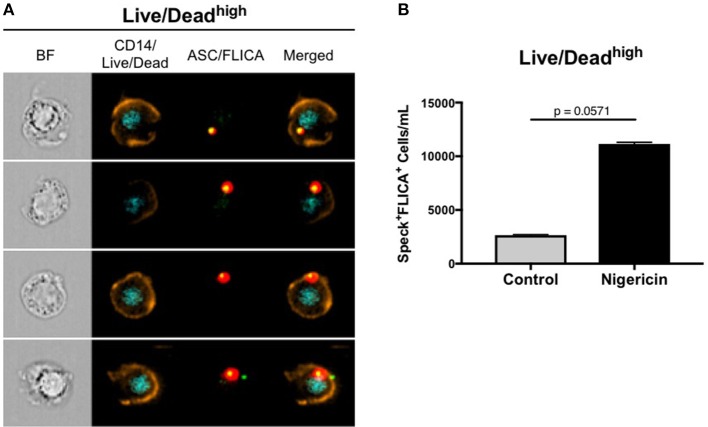
ImageStream can detect a Live/Dead AQUAhigh subset of cells in different stages of pyroptosis. (A) Representative images of speck+FLICA+ monocytes inside the Live/Dead AQUAhigh gate after pam3csk4 (0.5 ug/mL, 3 h) priming and Nigericin stimulation (3,5 uM, 1 h) were selected, showing, respectively: BF (brightfield), composite image containing the fluorescence of CD14 and Live/Dead AQUA, composite image of FLICA and ASC, followed by the merge of the two composites. Intensity fluorescence was augmented for the purpose of imagery, not affecting results, and statistics. (B) Quantification of Speck+FLICA+ monocytes/mL in control vs. nigericin-stimulated cultures after Area_Threshould(M11,11-ASC70) vs. Modulation_Morphology(M11,Ch11)_11-ASC dot-plot, followed by Bright Detail Similarity R3_MC_11-ASC_2-FLICA features were applied in all data. Numbers are the means ± SEM (n = 4). P = 0.0571 when Mann-Whitney test was applied.